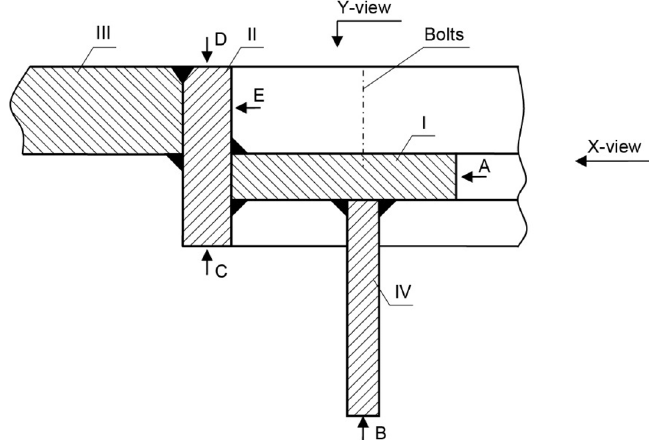
Figure 11. The indication of individual manhole parts from the handy-size bulk carrier 30206 DWT.